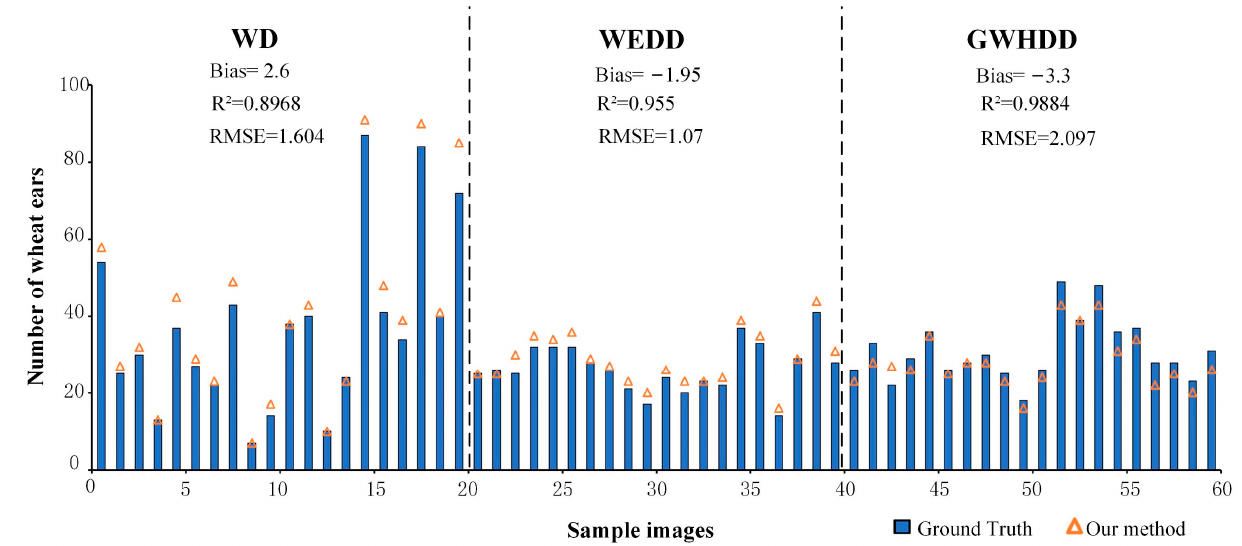
Figure 8. The comparison between the true value and the estimated value of a single image of different data sets.